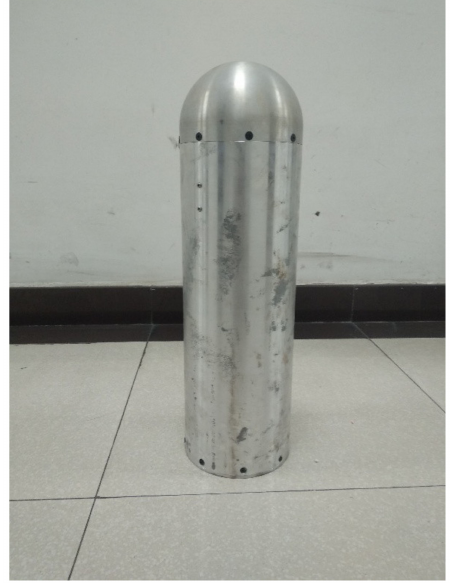
Figure 1. Designed flush air data sensing module.